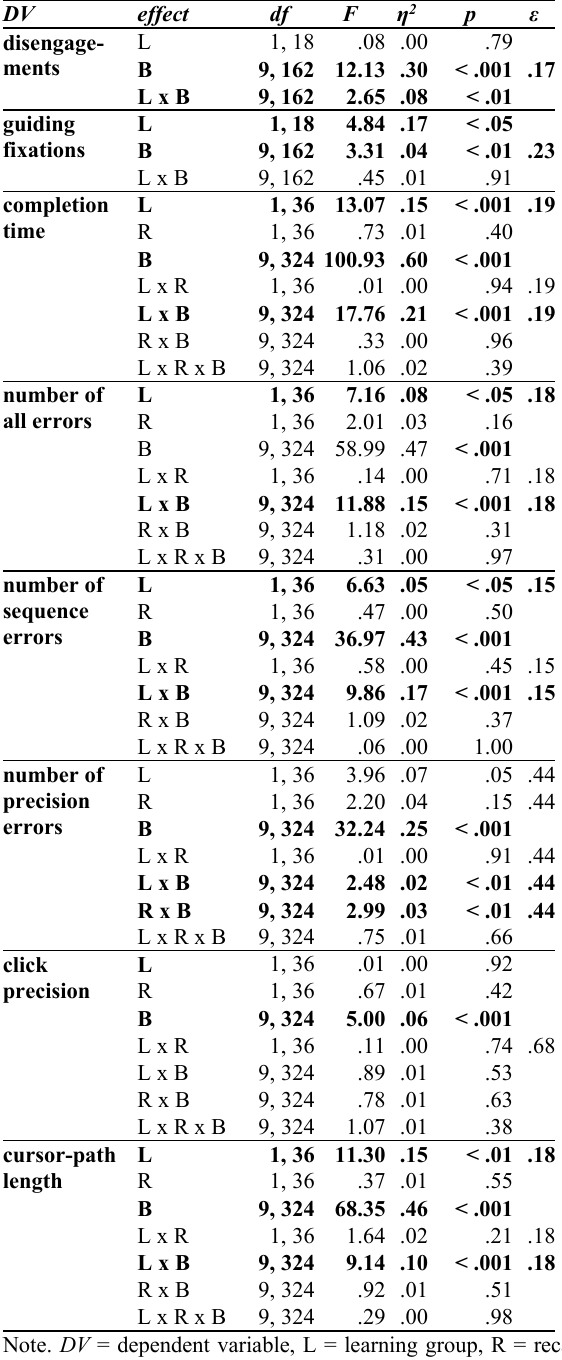
Table 6. ANOVA results of the recall phase of Experiment